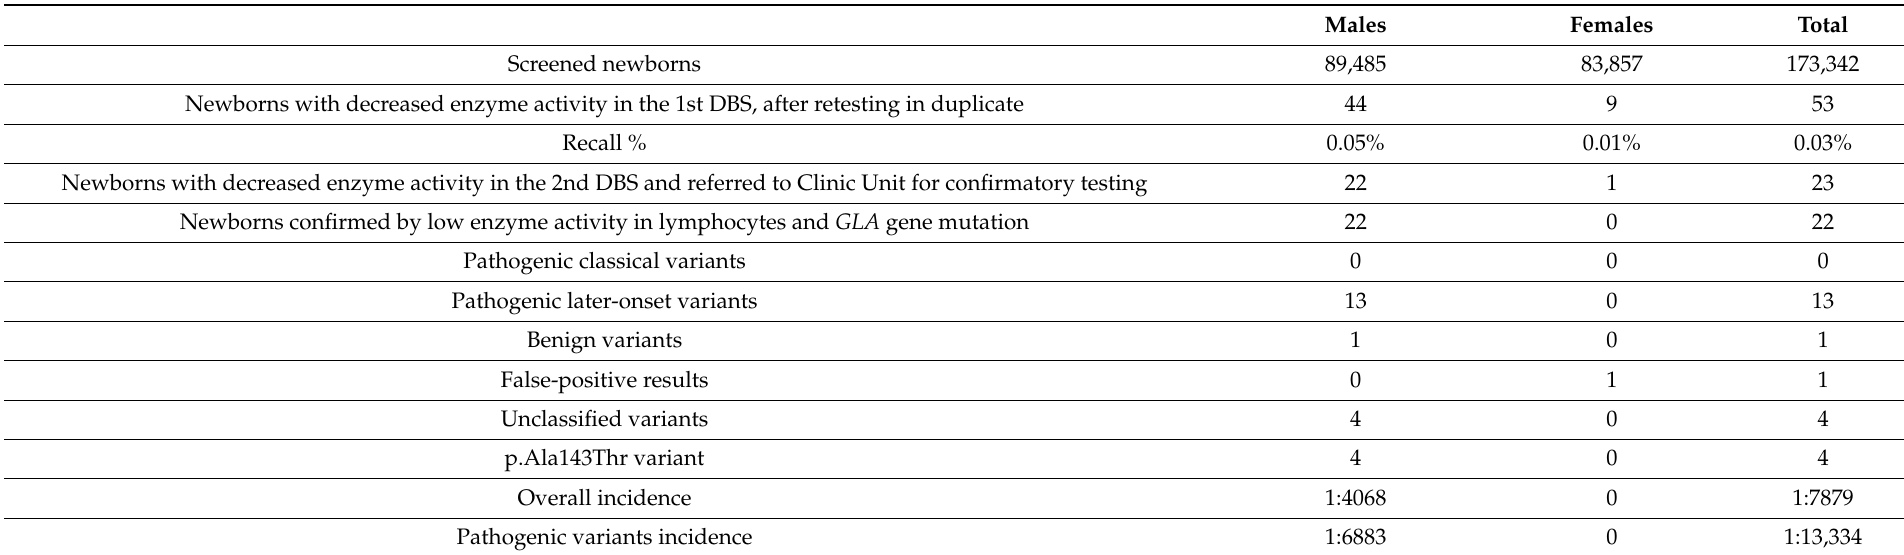
Table 2. Results of the newborn screening program for Fabry disease in northeast Italy (September 2015 to March